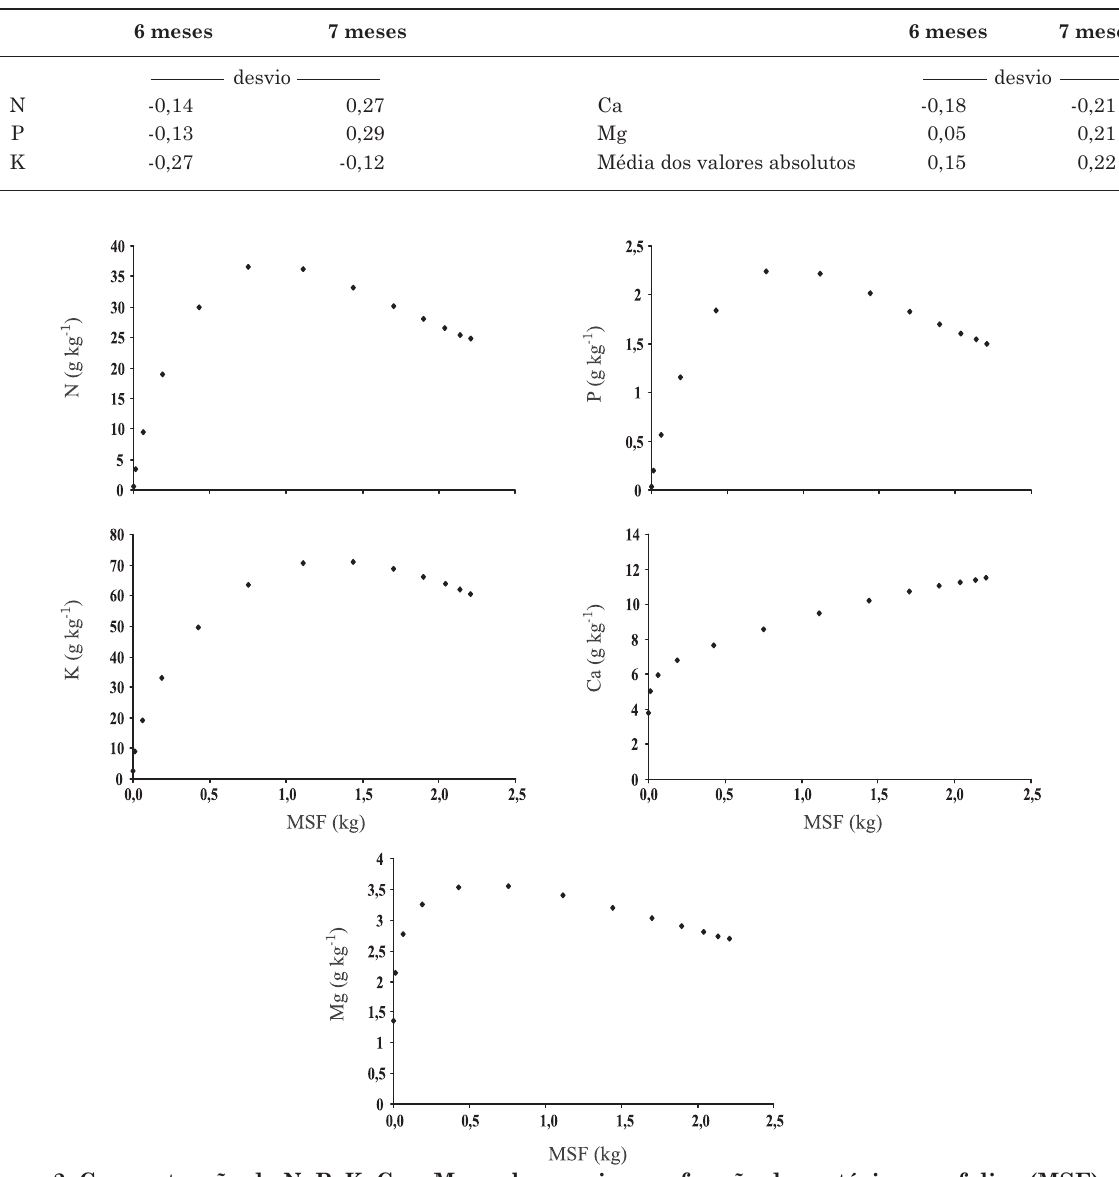
Figura 2. concentração de n, p, K, ca e mg na bananeira em função da matéria seca foliar (msF).